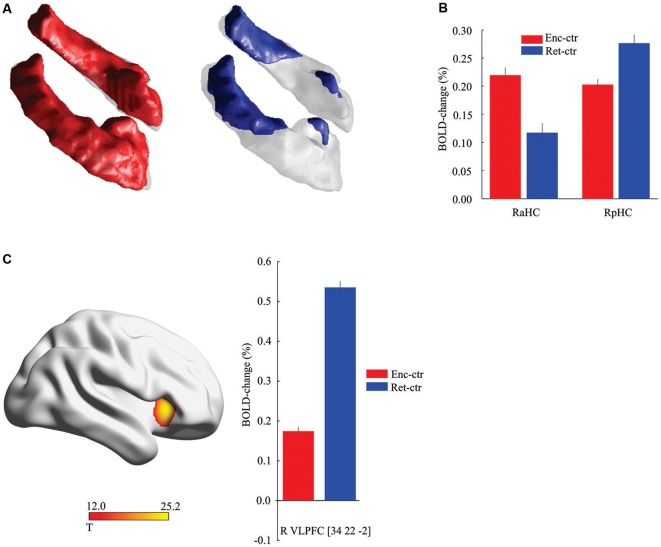
Hippocampal and frontal activation during encoding and retrieval. (A) Activation along the hippocampus longitudinal axis during encoding (red) and retrieval (blue) relative to control task (threshold, t > 8.0 for illustration). (B) Activity in the right anterior hippocampus (aHC) was stronger during encoding (P < 0.001, t(322) = 6.51), and in the right posterior hippocampus (pHC) at retrieval (P < 0.001, t(322) = 4.76). Data displayed from the peak voxels, collapsed across imaging sessions. (C). Differential recruitment of right frontal cortex during retrieval. Data displayed from the peak voxel, collapsed across imaging sessions. Ctr, control task. Vertical lines = ± Standard Error of Mean (SEM).